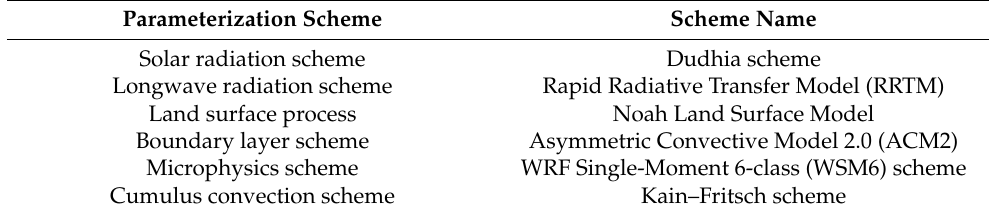
Table 2. Main physical parameterization schemes for the WRF